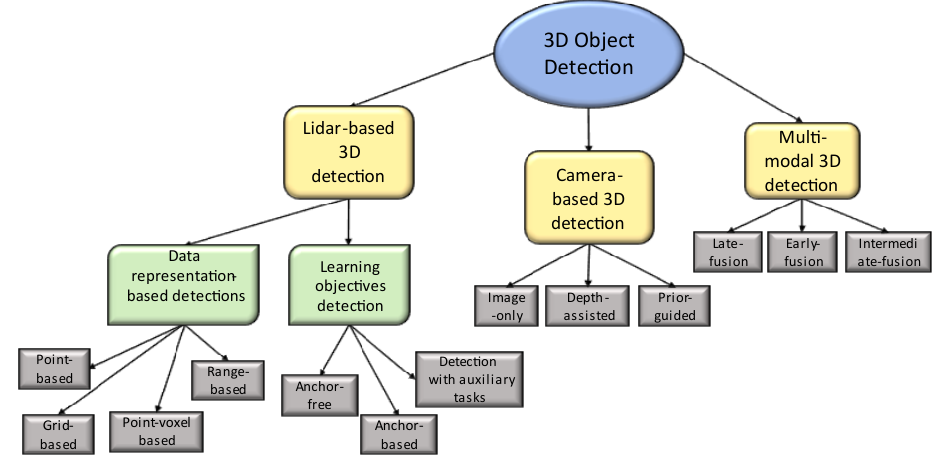
Figure 1. 3D object detection